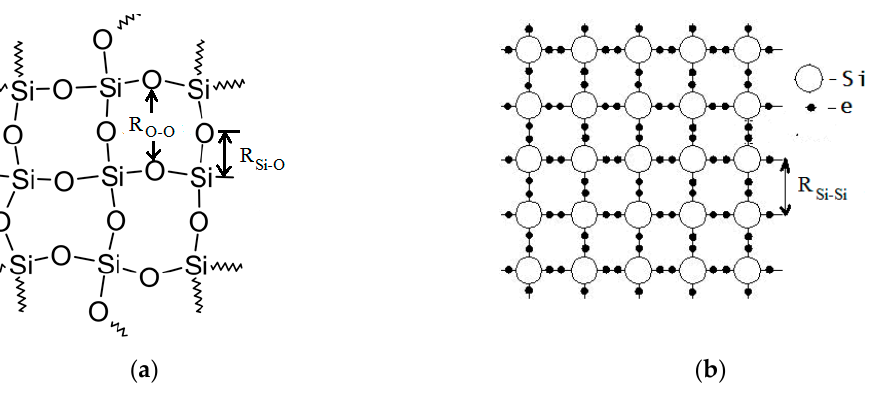
Figure 1. Model of the crystal lattices of ( a ) SiO 2 and ( b ) Si.